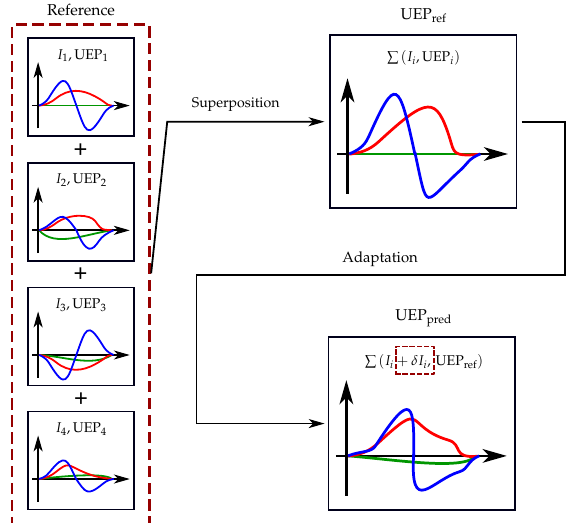
Figure 5. Schematic prediction principle for a four-zone ICCP system. For each electrode the UEP signature for corrosion protection is extracted and superimposed to achieve the reference UEP signature UEP ref . The present UEP signature is than calculated by utilizing the ICCP current changes at each ICCP electrode δ I i as a linear scaling factor. For weak corrosion processes the UEP signature changes can be solely described by the changes of the ICCP